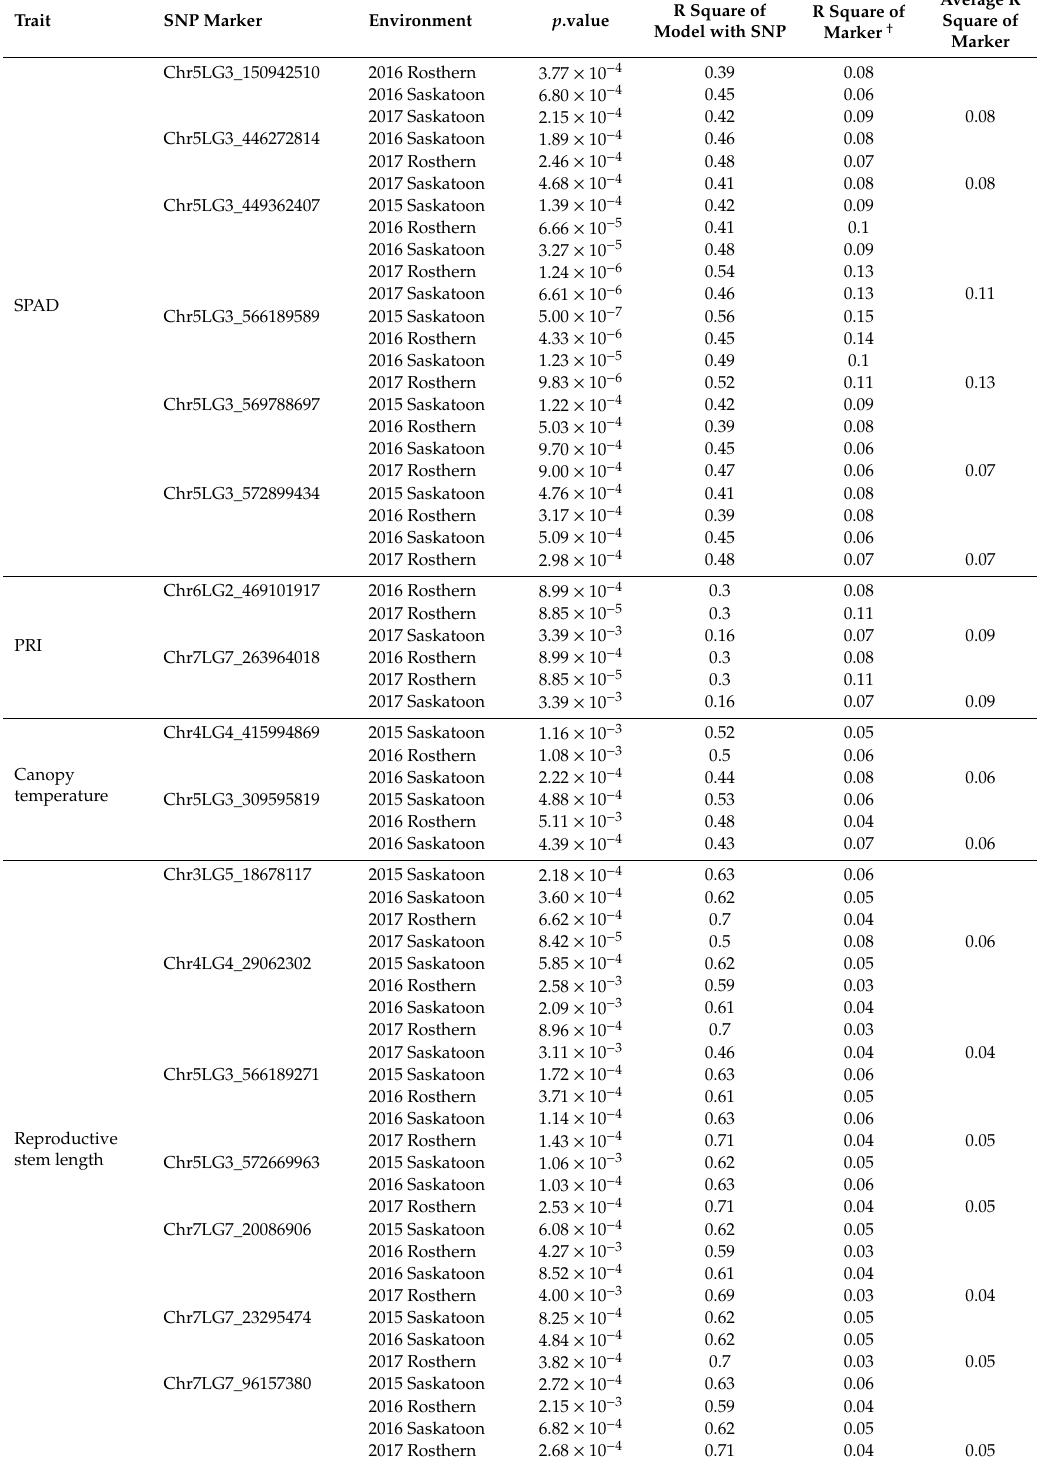
Table 4. Trait-linked SNP markers identified by association analysis of pea phenotypes associated with heat stress using the mixed linear model